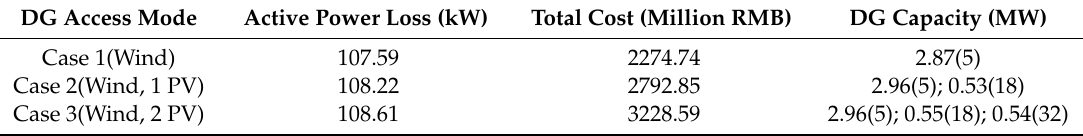
Table 1. Results of kernel extreme learning machine without electric vehicle; (DG: distributed